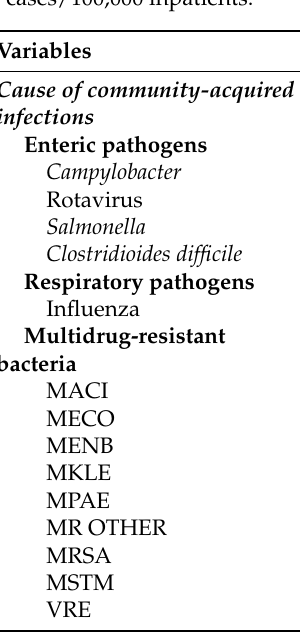
Table 2. Distribution of patients by type community-acquired infections, hospital ward and number of cases/100,000